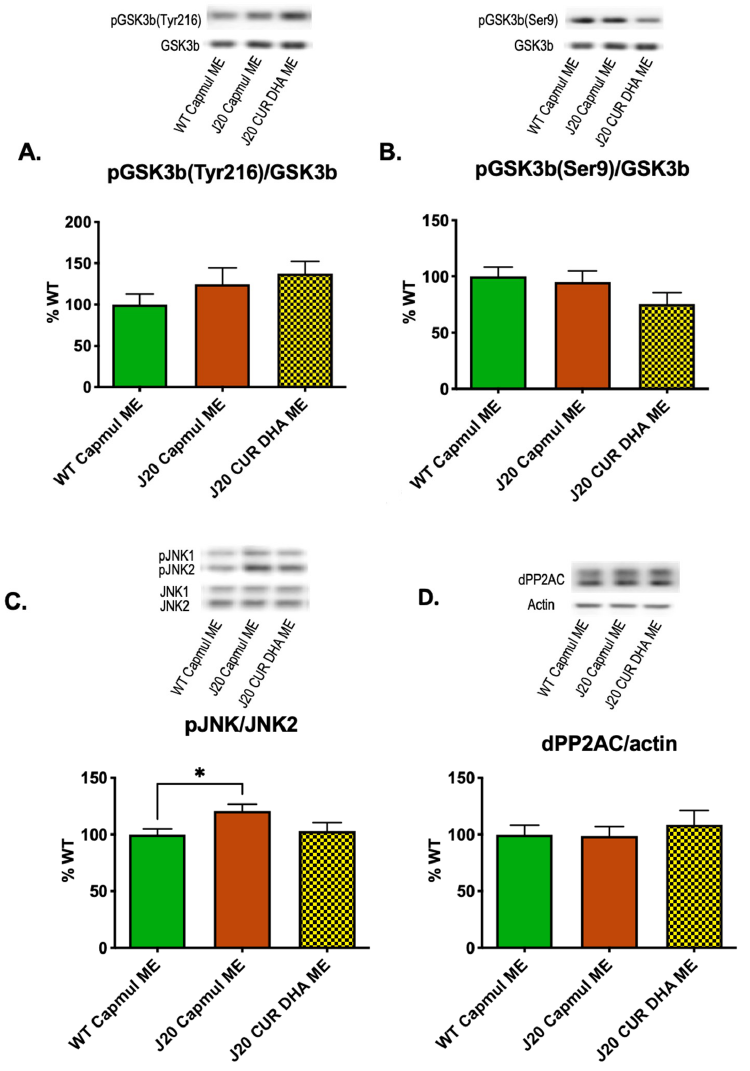
Figure 6. Effect of intranasal administration of CURDHA-ME on Tau kinases and phosphatase in transgenic J20 mice. Effect of intranasal administration of CURDHA-ME on GSK3 β phospho-epitope Tyr216 levels that reflect its activation ( A ) and Ser9 levels that reflect its inactivation ( B ) by immunoblot analysis of hippocampal lysates from J20 mice. ( C ) Effect of intranasal administration of CURDHA-ME on Phospho-JNK levels by immunoblot analysis of hippocampal lysates from J20 mice (One-Way ANOVA followed by a Tukey post-hoc test, * p < 0.05 vs. WT mice). ( D ) Effect of intranasal administration of CURDHA-ME on the major Tau phosphatase, PP2AC, by immunoblot analysis of hippocampal lysates from J20 mice. The demethylated/total PP2AC ratio was calculated as a reflection of its inactivation. WT and J20 mice received a ME-containing Capmul oil as a vehicle. All the results are normalized to total corresponding protein levels and expressed as the percentage of the control (WT CAPMUL ME).